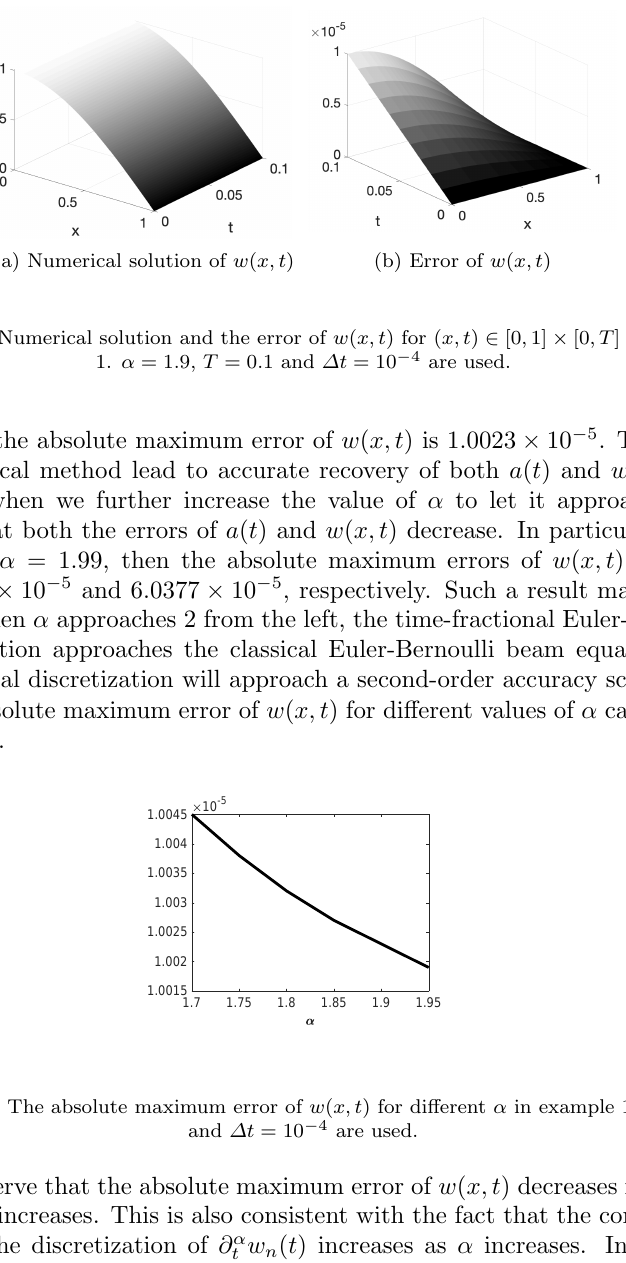
show that the absolute maximum error of w ( x, t ) is 1 . 0023 × 10 − 5 . Therefore,